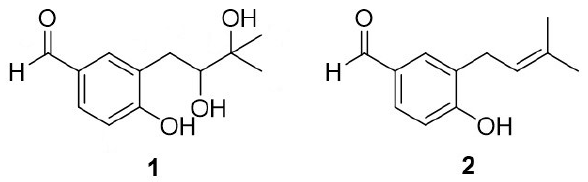
Figure 10. The structures of benzaldehydes 1 - 2 .